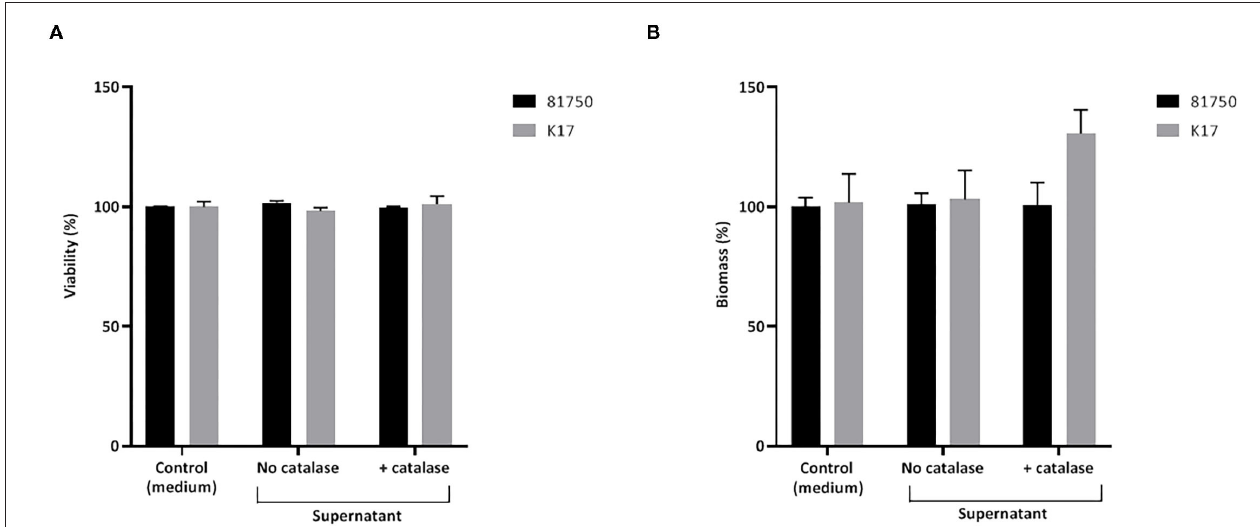
FIGURE 5 | Effect of a culture supernatant of S. pluranimalium 2N12, treated or not with catalase, on the viability (A) and biomass (B) of A. pleuropneumoniae 81750 and K17 biofilms. Biofilm viability was assessed using the FilmTracer LIVE/DEAD Biofilm Viability kit. Biofilm biomass was determined by crystal violet staining. Assays were performed in triplicate in three independent experiments, and the means ± SD were calculated.